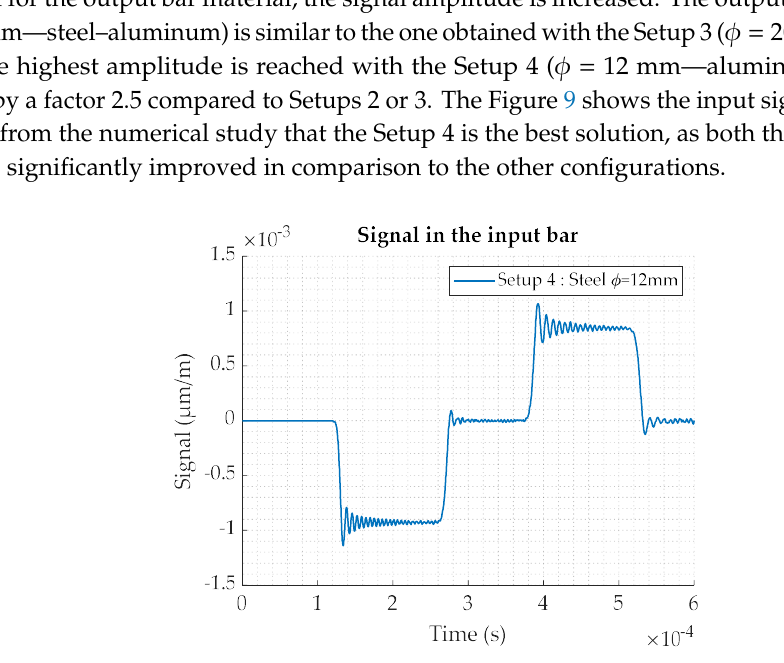
Figure 9. Input signal for the Setup 4, obtained by numerical simulation.